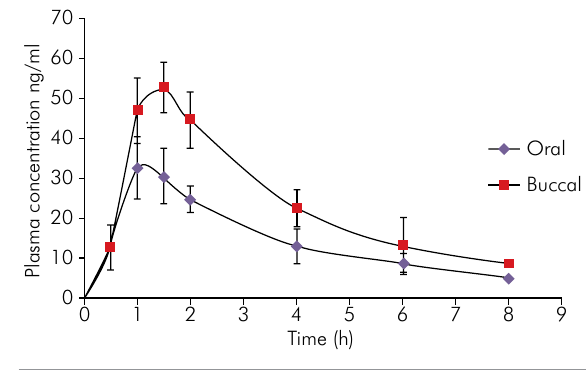
Figure 5. Comparison of plasma concentration profiles following buccal application of zolpidem nanosphere-loaded buccal film Z4 versus oral administration in rabbits. Values represent the mean of six trials ± standard